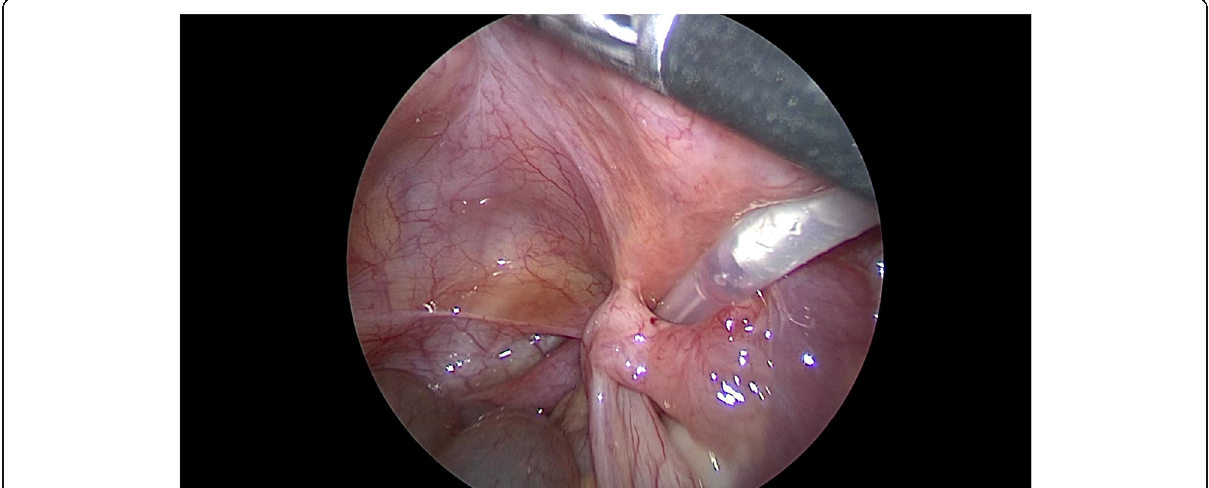
Fig. 5 Wrapping of tube by right fallopian